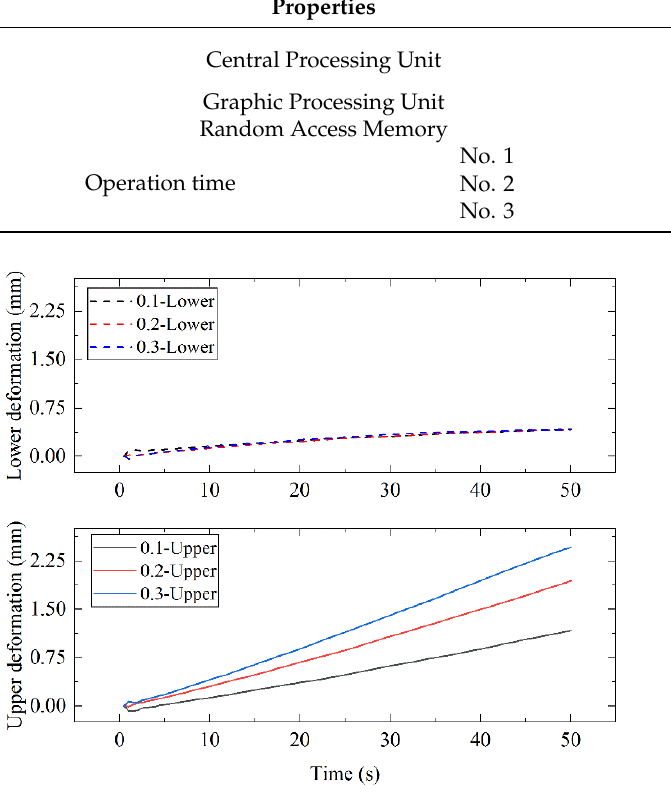
Figure 10. The deformation of the glass preform in the three simulations.